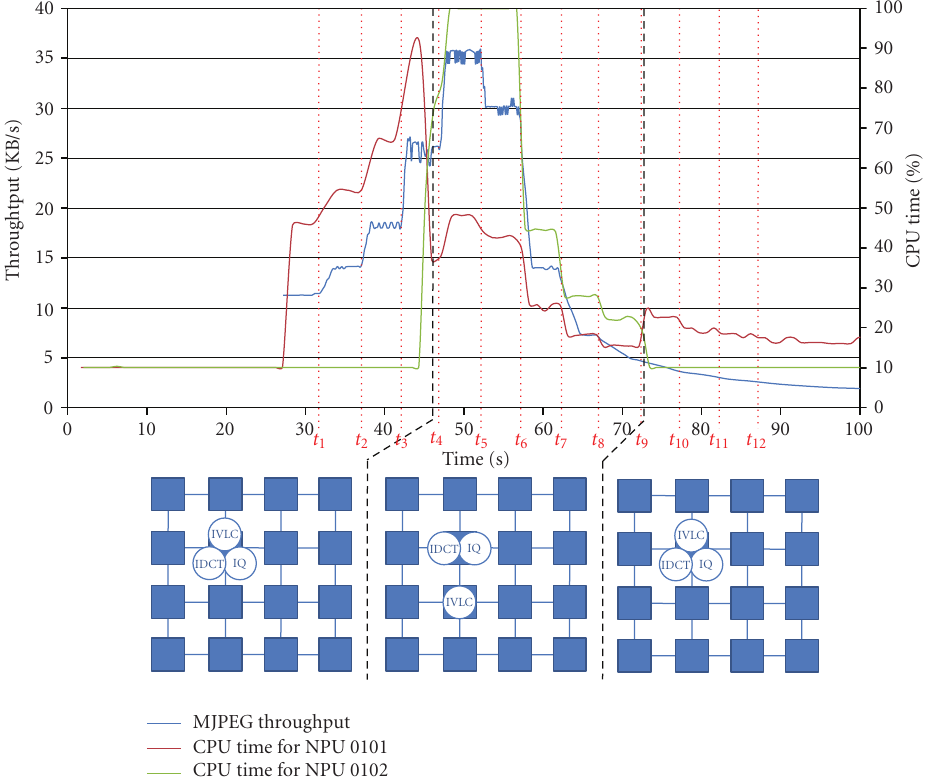
Figure 23: MJPEG decoder throughput based on CPU